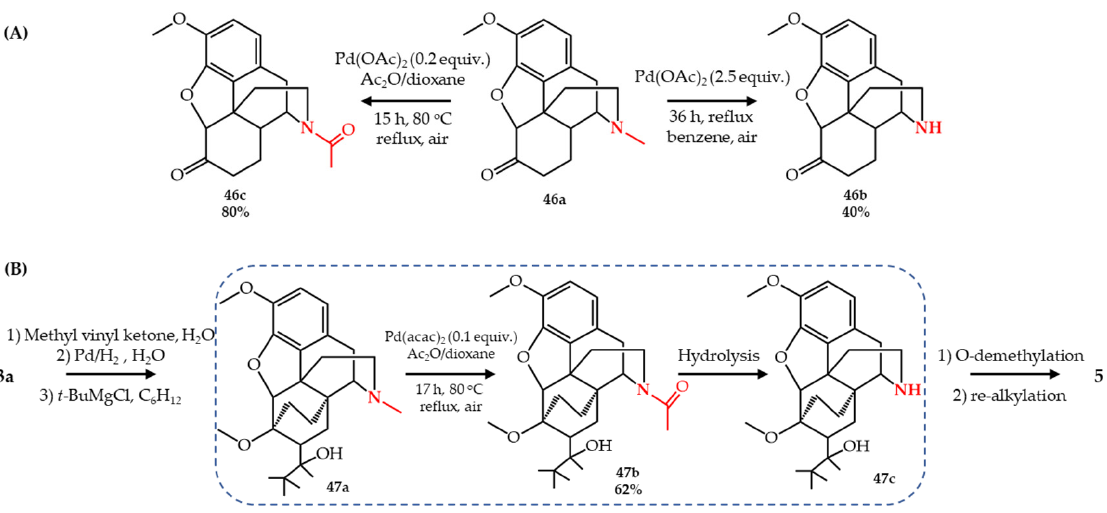
Figure 6. Pd-catalyzed N -demethylation/ N -acylation of opiates of ( A ) hydrocodone ( 46a ) and ( B ) oripavine ( 3a ).